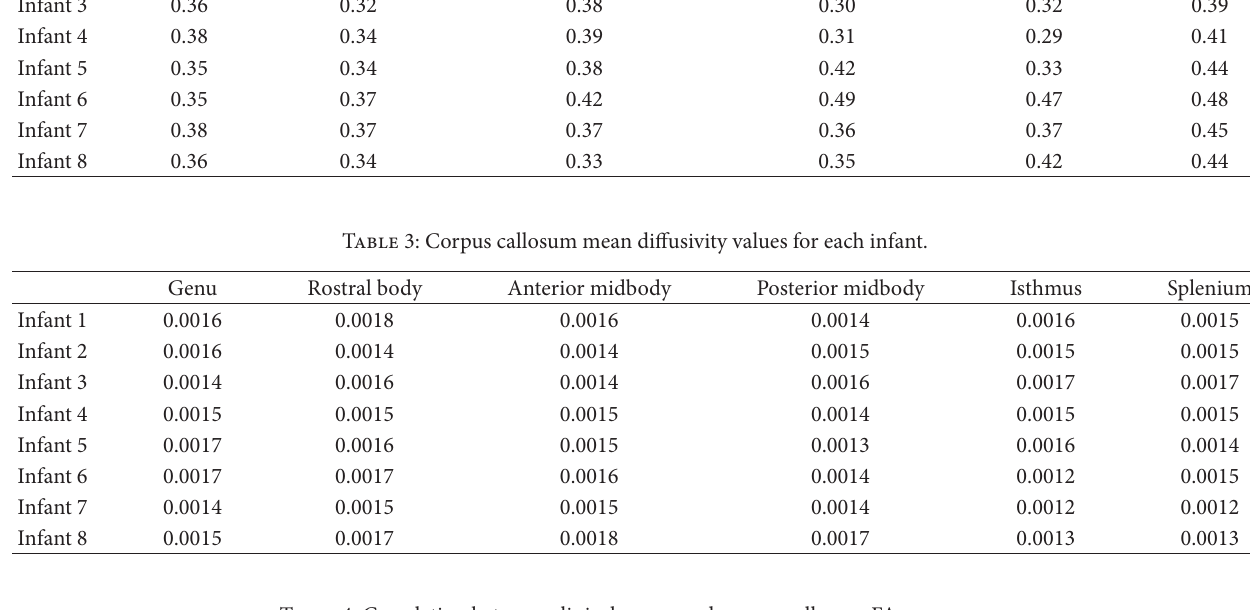
T 4: Correlation between clinical scores and corpus callosum FA measures.